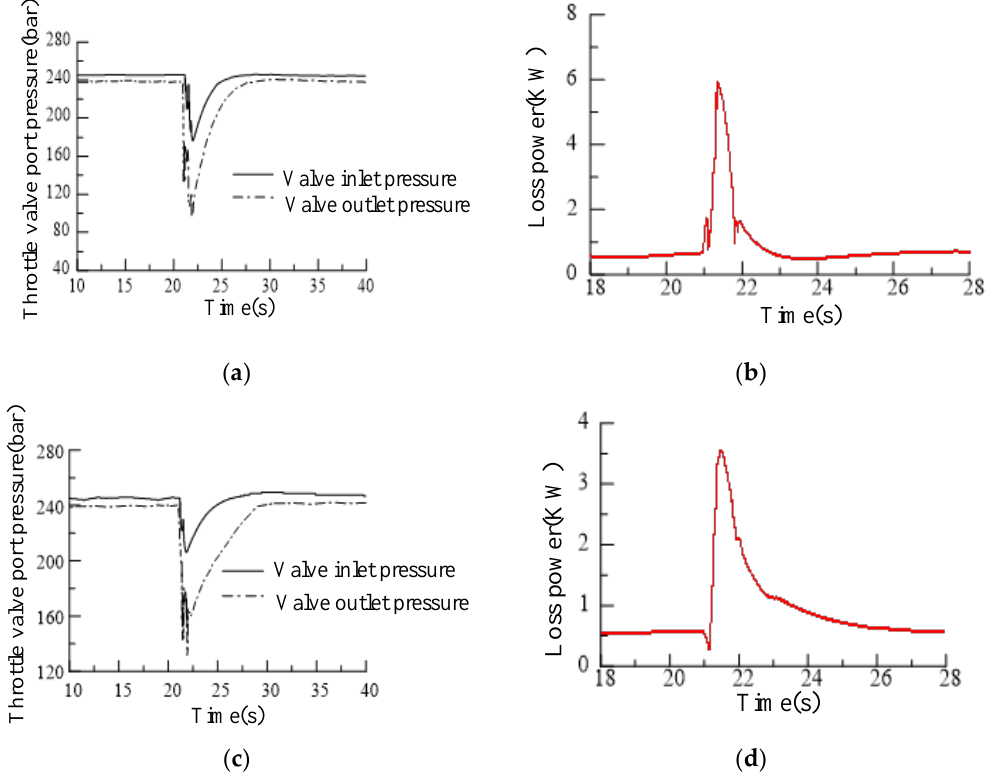
Figure 12. Simulation curve of HWT voltage drop when applying underlying control. ( a ) System pressure simulation curve when single-phase drops 80%; ( b ) Dissipation energy simulation curve of throttle valve when single-phase drops 80%; ( c ) System pressure simulation curve when three-phase drops 20%; ( d ) Simulation curve of throttle dissipating energy when three-phase drops 20%.